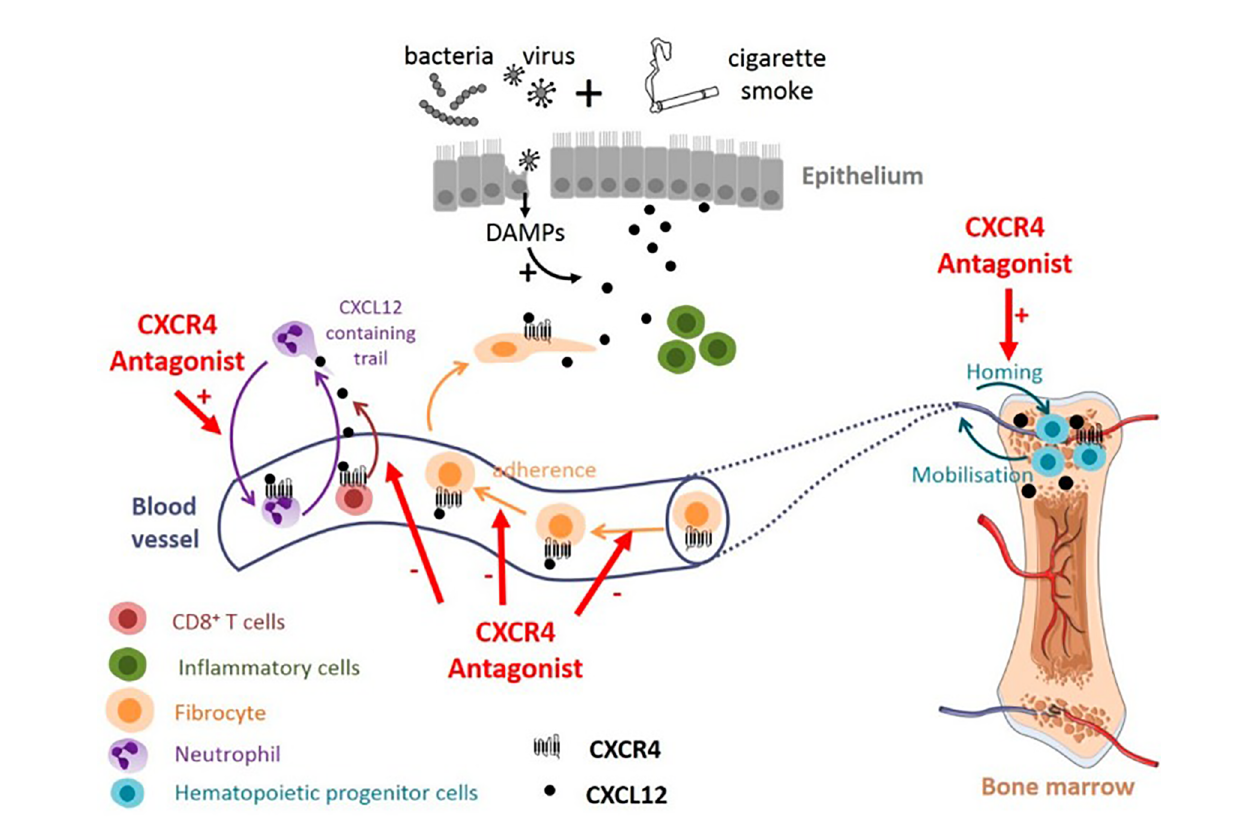
FIGURE 6 | Potential effect of targeting CXCL12/CXCR4 axis in COPD. CXCR4 antagonists could promote neutrophil demargination from the lungs and inhibit T- cells and fi brocytes recruitment into bronchial tissue. CXCR4 antagonists may also contribute to maintaining the pool of hematopoeitic progenitor cells in the bone marrow, available for tissue repair